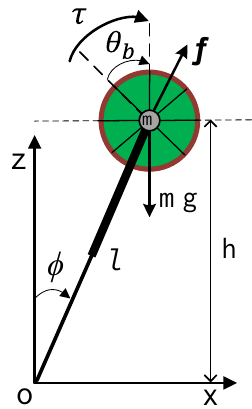
Figure 7. Graphical description of a linear inverted pendulum with a flywheel model.